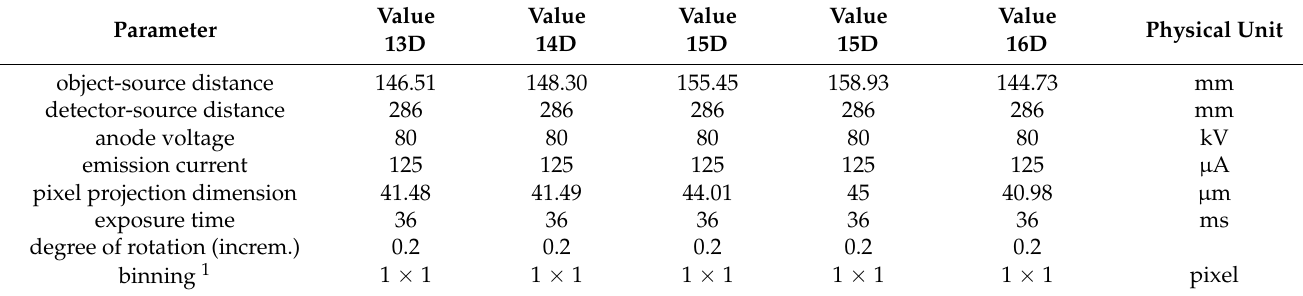
Table A9. Values of set parameters on SkyScan 1275.